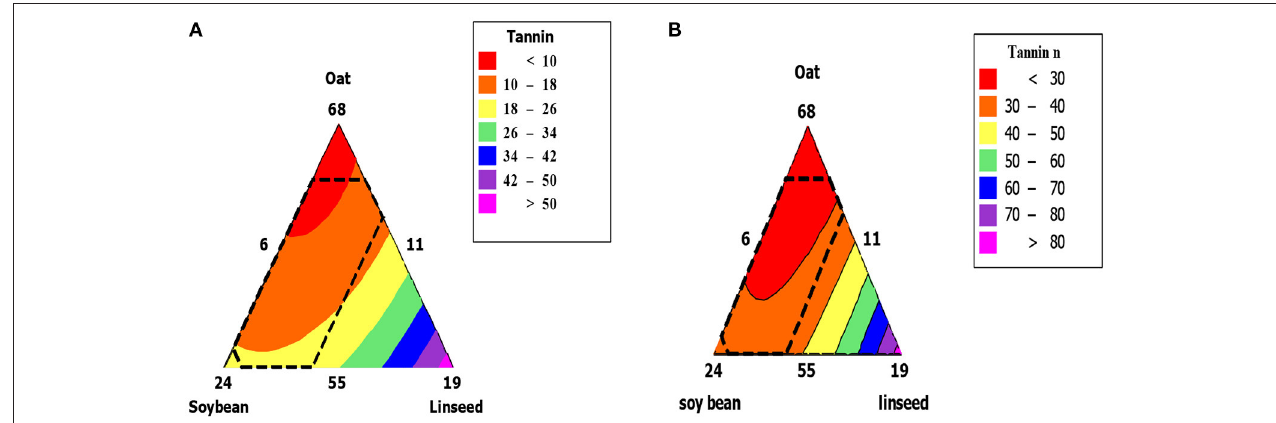
FIGURE 3 | Contour plot of tannin content (mg/100g) of extruded (A) and unextruded composite flour (B) .